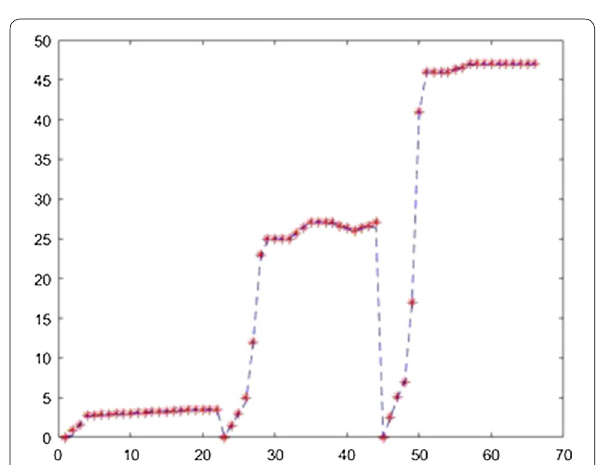
Fig. 7 Model results obtained with Levenberg–Marquardt method